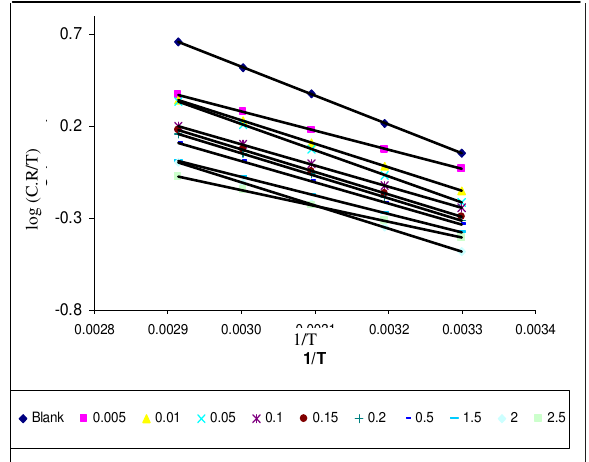
Figure 1 . Arrhenius plots for mild steel dissolution process in 1 M HCl.